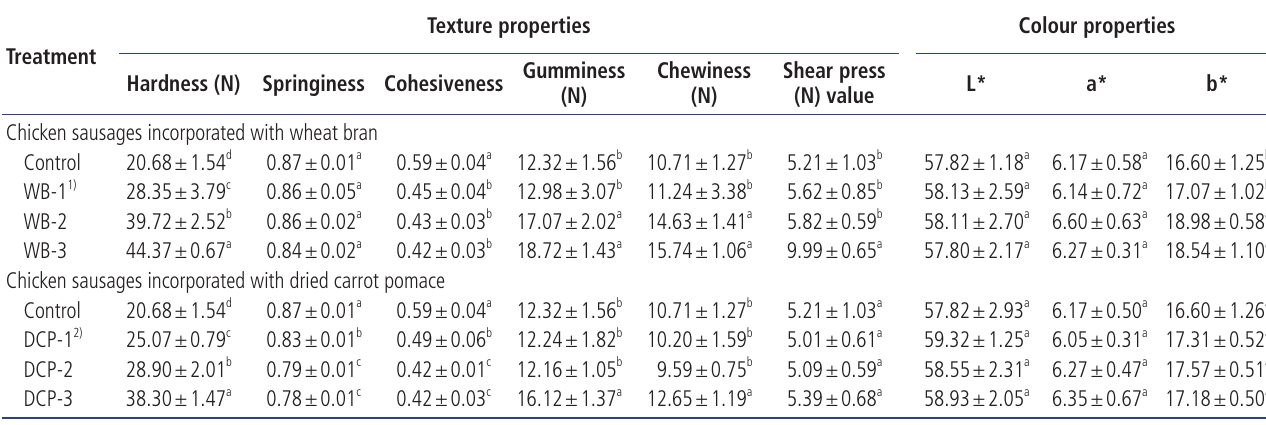
Table 4. Instrumental texture and colour properties of chicken sausages incorporated with different levels of wheat bran, dried carrot pomace